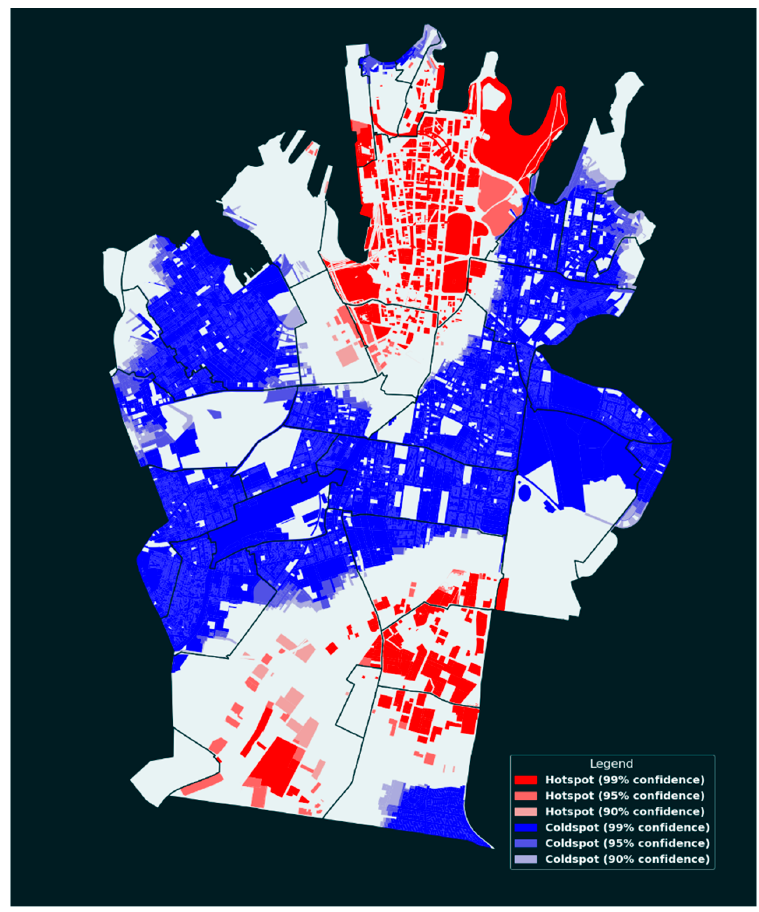
Figure 27. Estimated cost hot and cold spots across all years (2005–2021).